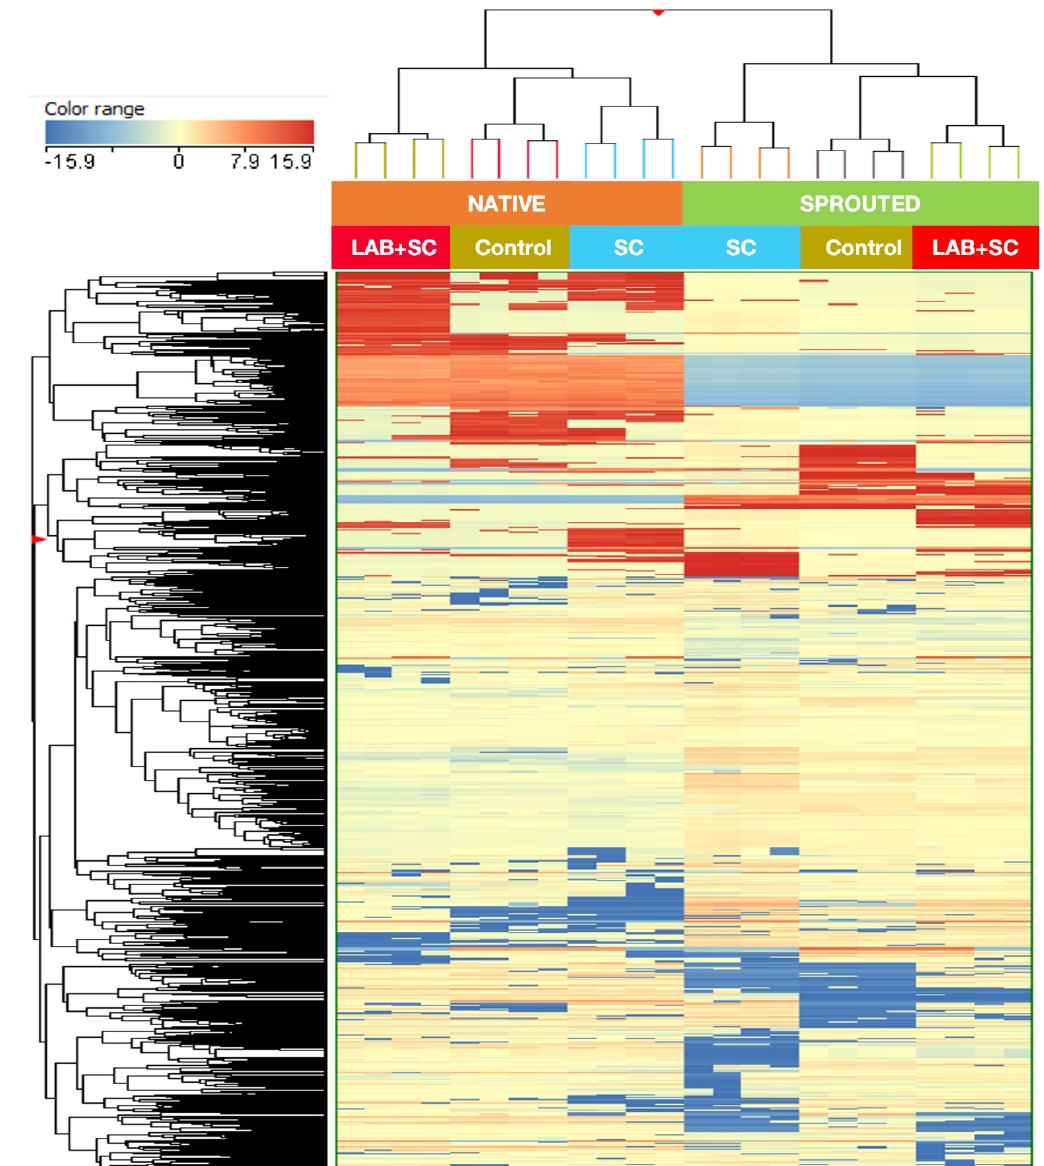
Figure 5. Unsupervised hierarchical cluster analysis on the untargeted metabolic profiling of rye dough. The fold change values, represented by a color range, for each compound were calculated with respect to the median of all samples, and further used to obtain a fold change ‐ based heatmap, according to Ward’s algorithm (Euclidean distance). The factors involved in clustering were NATIVE and SPROUTED, for native and sprouted ‐ derived rye sourdough, respectively; and control, SC, and LAB + SC, for unfermented, yeast ‐ fermented and yeast and LAB ‐ combined fermented rye sourdough, respectively.